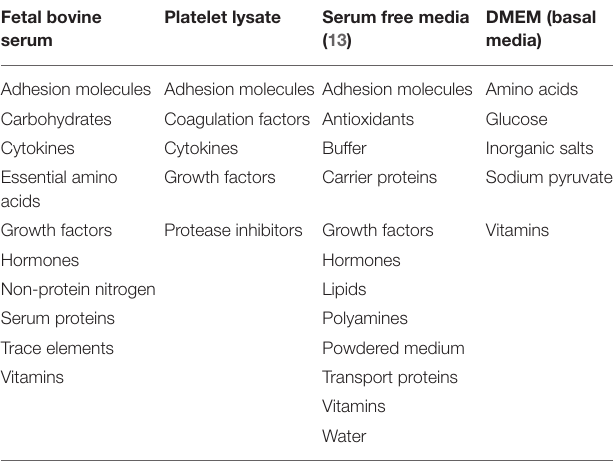
TABLE 1 | Components of different media including FBS, PL, SFM, and